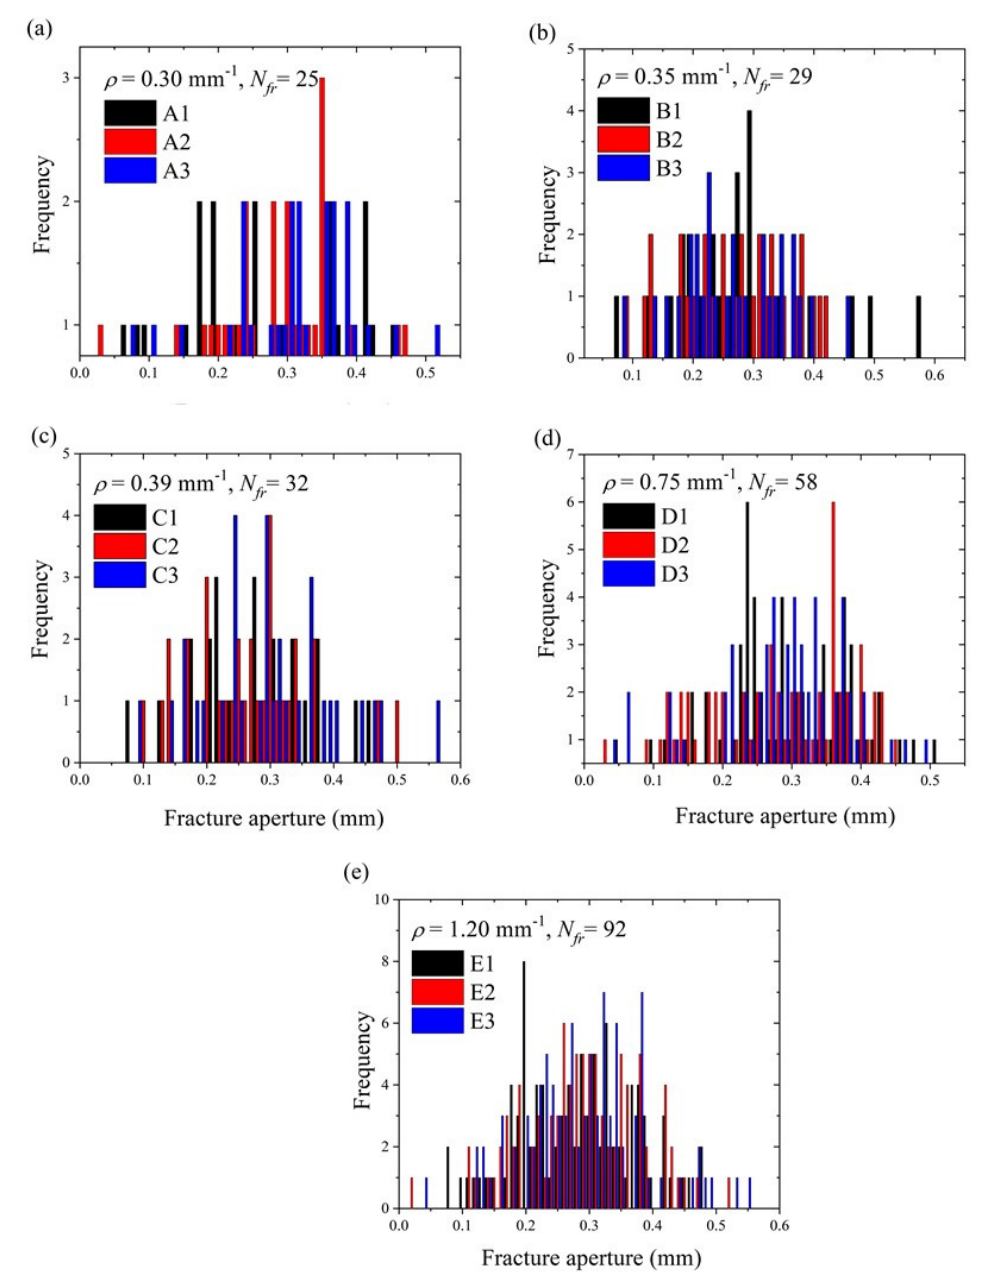
Figure 3. Fracture aperture frequency distribution for models with various fracture densities. The horizontal axis represents the fracture aperture, while the vertical axis represents the fracture frequency with a certain aperture for models with various fracture densities. The data were obtained from three models at each fracture density: ( a ) ρ = 0.30 mm − 1 , N fr = 25; ( b ) ρ = 0.35 mm − 1 , N fr = 29; ( c ) ρ = 0.39 mm − 1 , N fr = 32; ( d ) ρ = 0.75 mm − 1 , N fr = 58; ( e ) ρ = 1.20 mm − 1 , N fr =